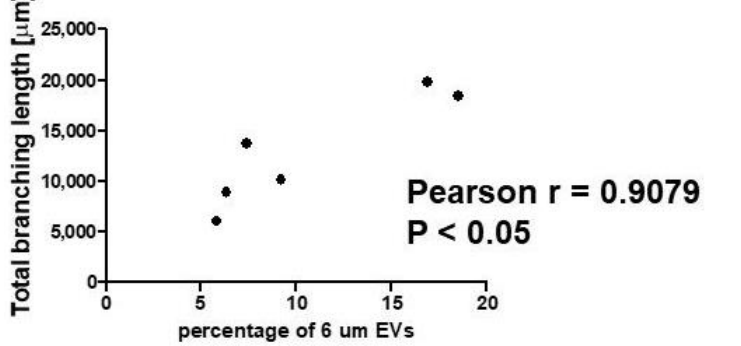
Figure 10. Pearson correlation between the percentage of 6- µ m extracellular vesicles (EVs) released by cells and their pro-angiogenic potential.